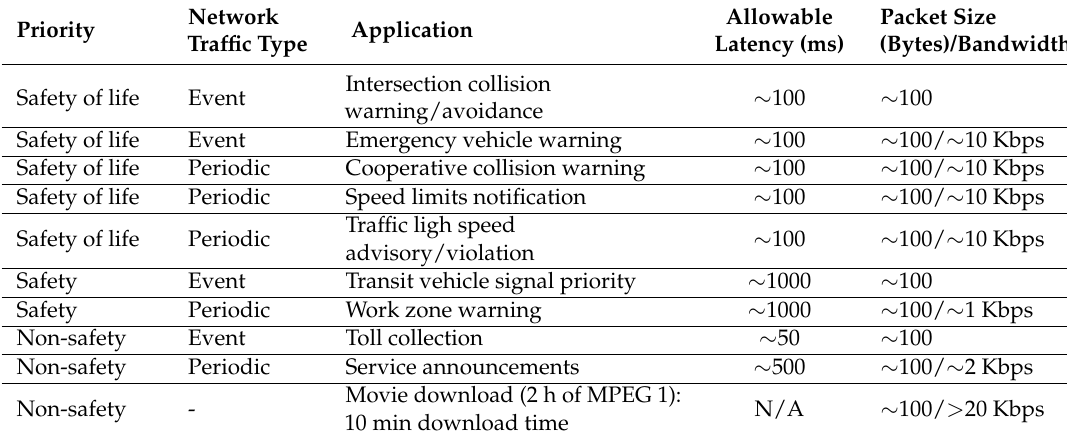
Table 1. DSRC data traffic requirements